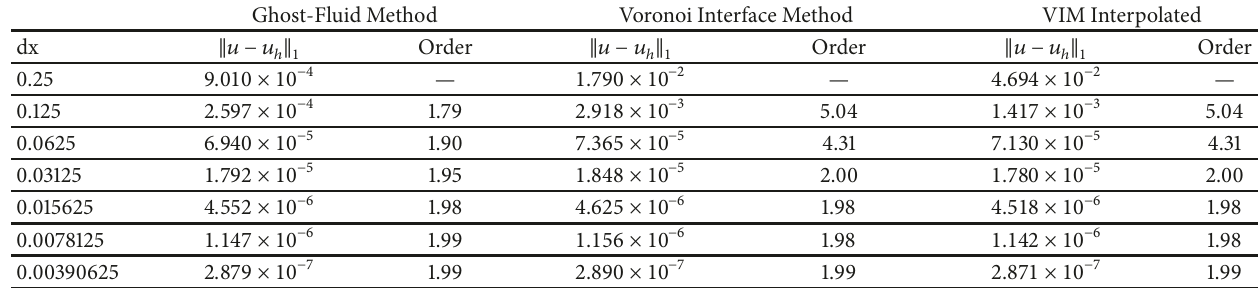
Table 2: Comparison of the 𝐿 1 error in the solution for the Ghost-Fluid Method and the Voronoi Interface Method, for example, shown in Section